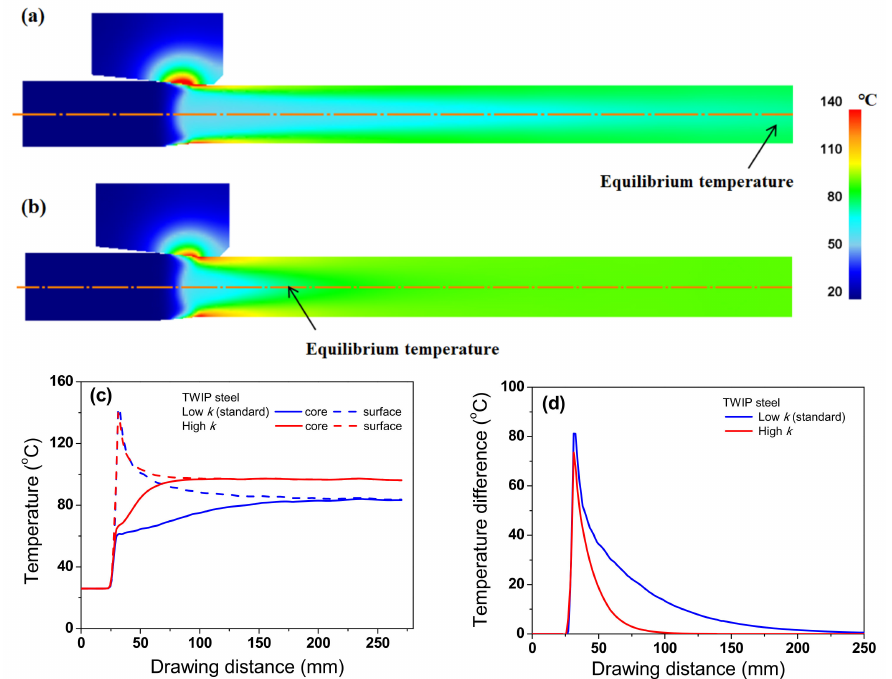
Figure 11. Comparison of temperature contour of TWIP steel with ( a ) standard and ( b ) high thermal conductivities. Comparison of ( c ) temperature profiles along the drawing direction at core and surface regions and ( d ) temperature difference between core and surface regions of TWIP steel.